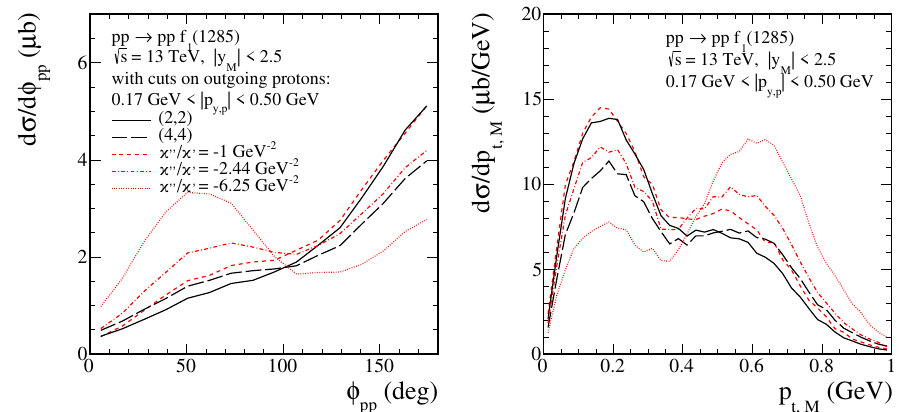
(cid:112) ( 1285 ) production at s = 13 TeV, 1 | < 0.50 GeV. y , p